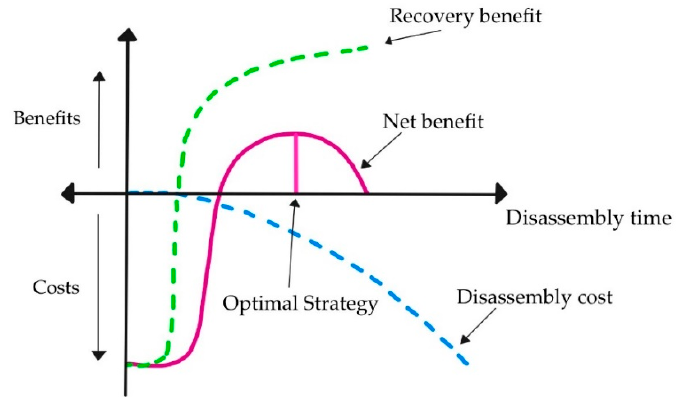
Figure 1. Total cost function for the Design for Disassembly (DfD)